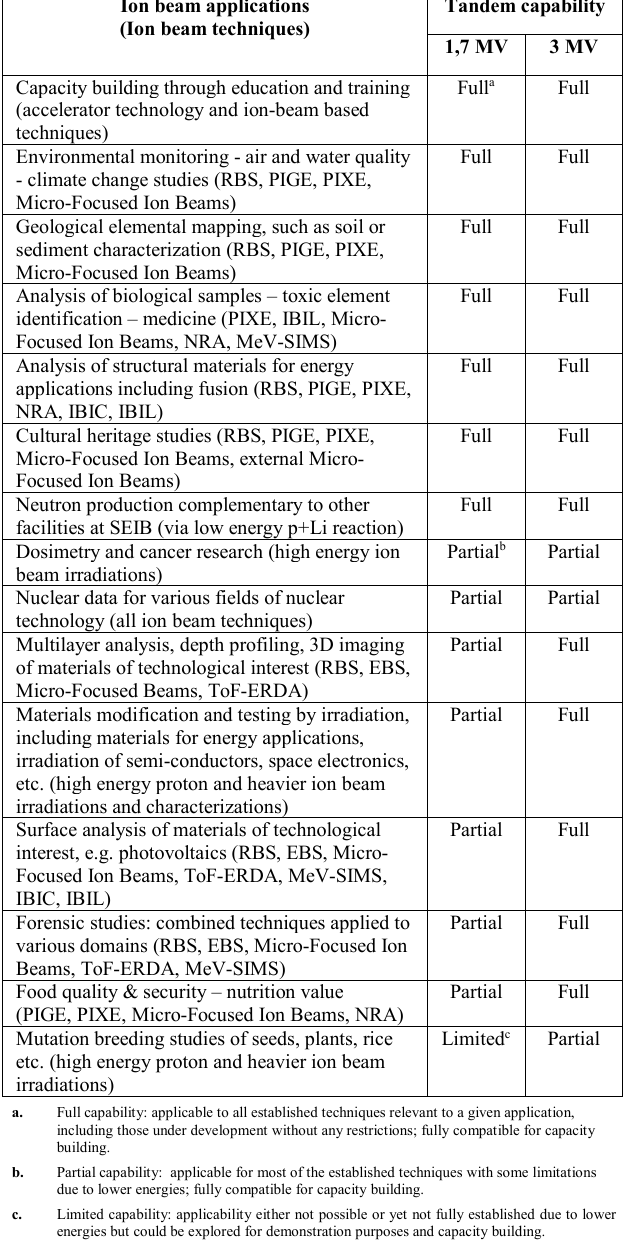
T ARGETED ION BEAM APPLICATIONS AND TECHNIQUES AS WELL AS PROPOSED ACCELERATOR OPTIONS , WITH THEIR RESPECTIVE CAPABILITIES , FOLLOWING THE FEASIBILITY CONDUCTED IN